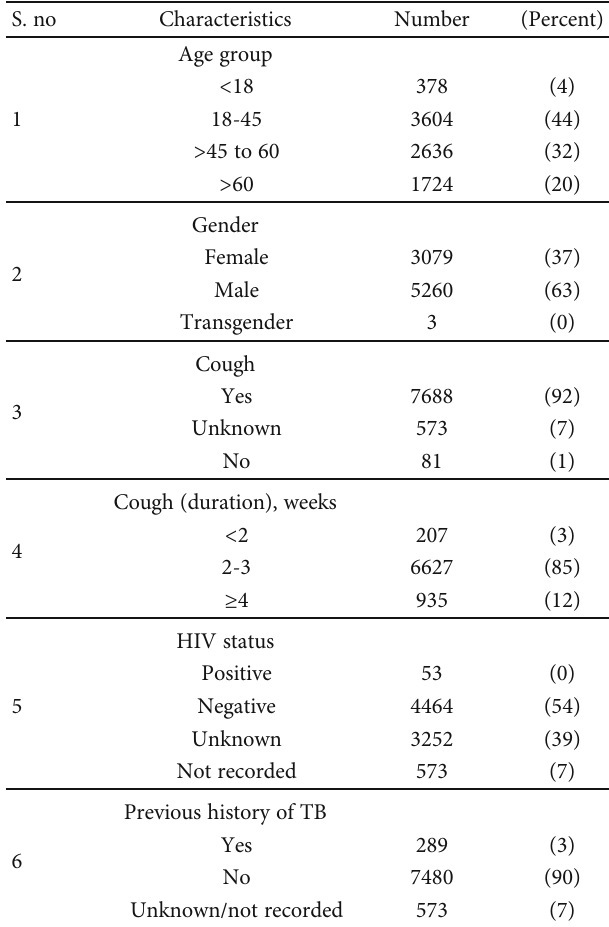
Table 4: Characteristics of persons with presumptive TB enrolled under RIPENED project, Telangana State, India, during 2018-19 ( N = 8342